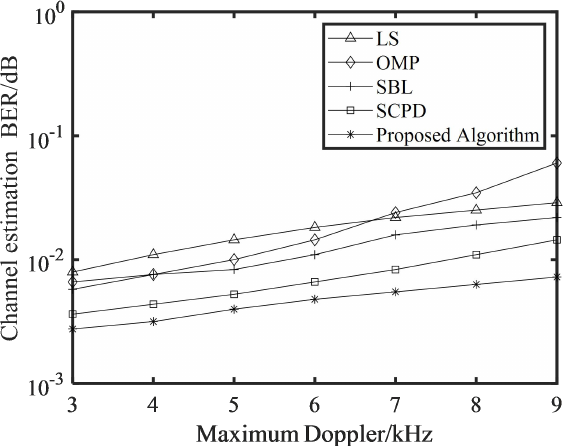
Figure 8. BER versus maximum Doppler shift f max . Simulation setup: the number of transmit antennas N R = 16, and the transmit RF chains M R = 16; the number of receive antennas N V = 4, and the receive RF chains M V = 4.The number of vehicles is 4, and the distance between vehicles is greater than 50